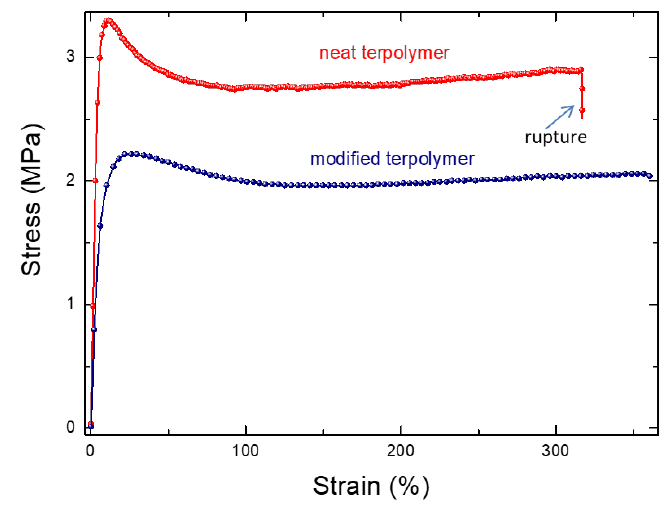
Figure 4. Longitudinal strain versus stress for different electrostrictive composites.